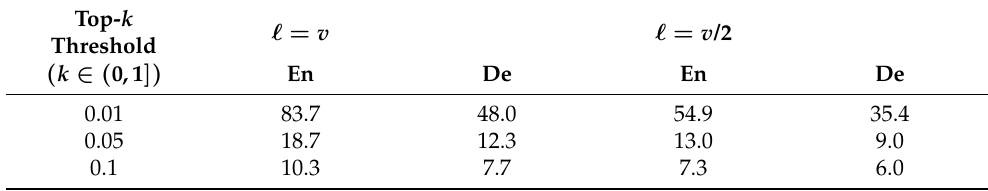
Table 4. Depth of label assignment in LCP-dropout.